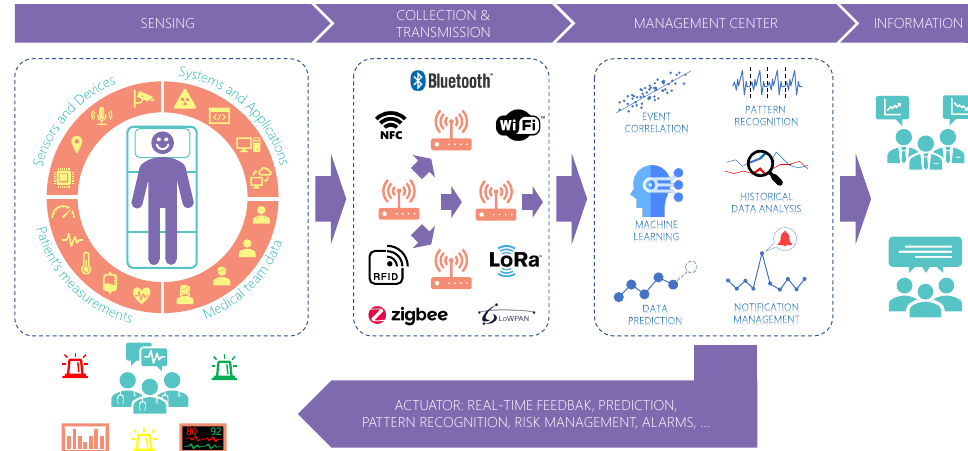
Figure 1. Real-time data acquisition, analysis, and feedback in healthcare. Sensors close to the patient and medical staff generate numerous information collected and transmitted for remote processing. Several applications can profit from this information for further analysis and real-time feedback to